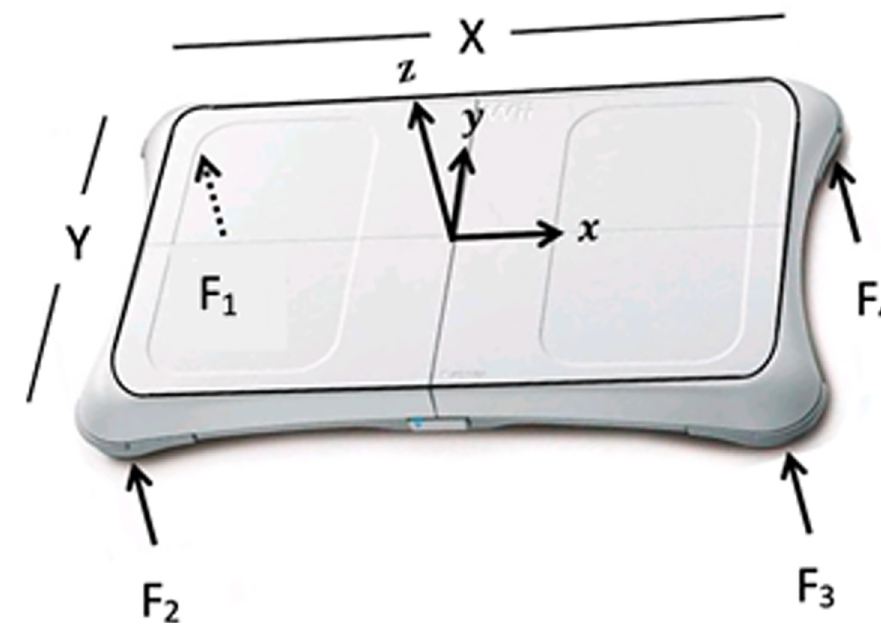
Fig 2. Wii balance board: Reference system and vertical forces recorded at the four corners F1, F2, F3, F4. Y-axis and X-axis are associated with antero-posterior and medio-lateral directions, respectively.